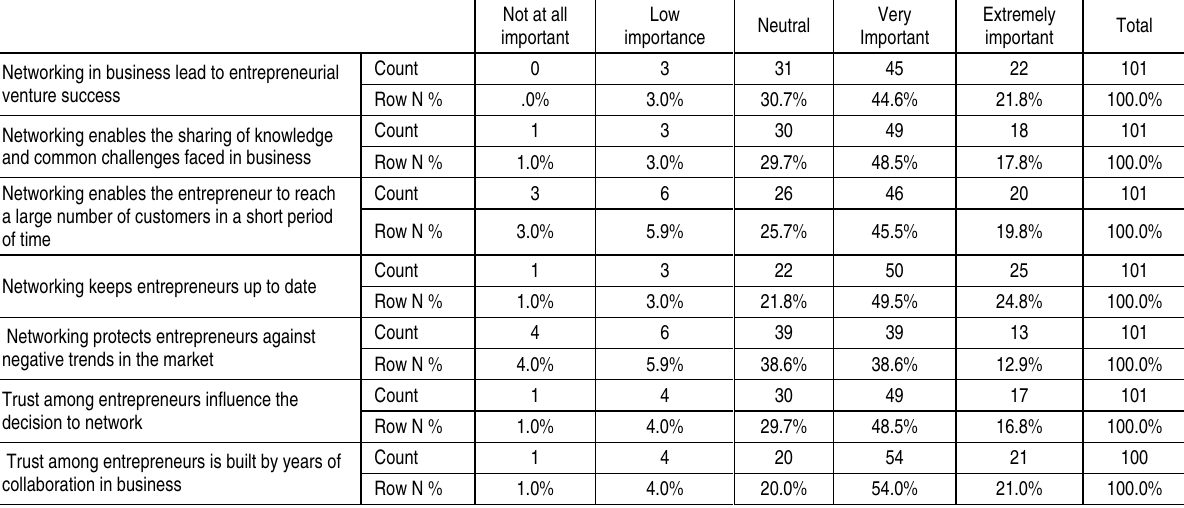
Table 3. The skill of networking and trust – level of importance